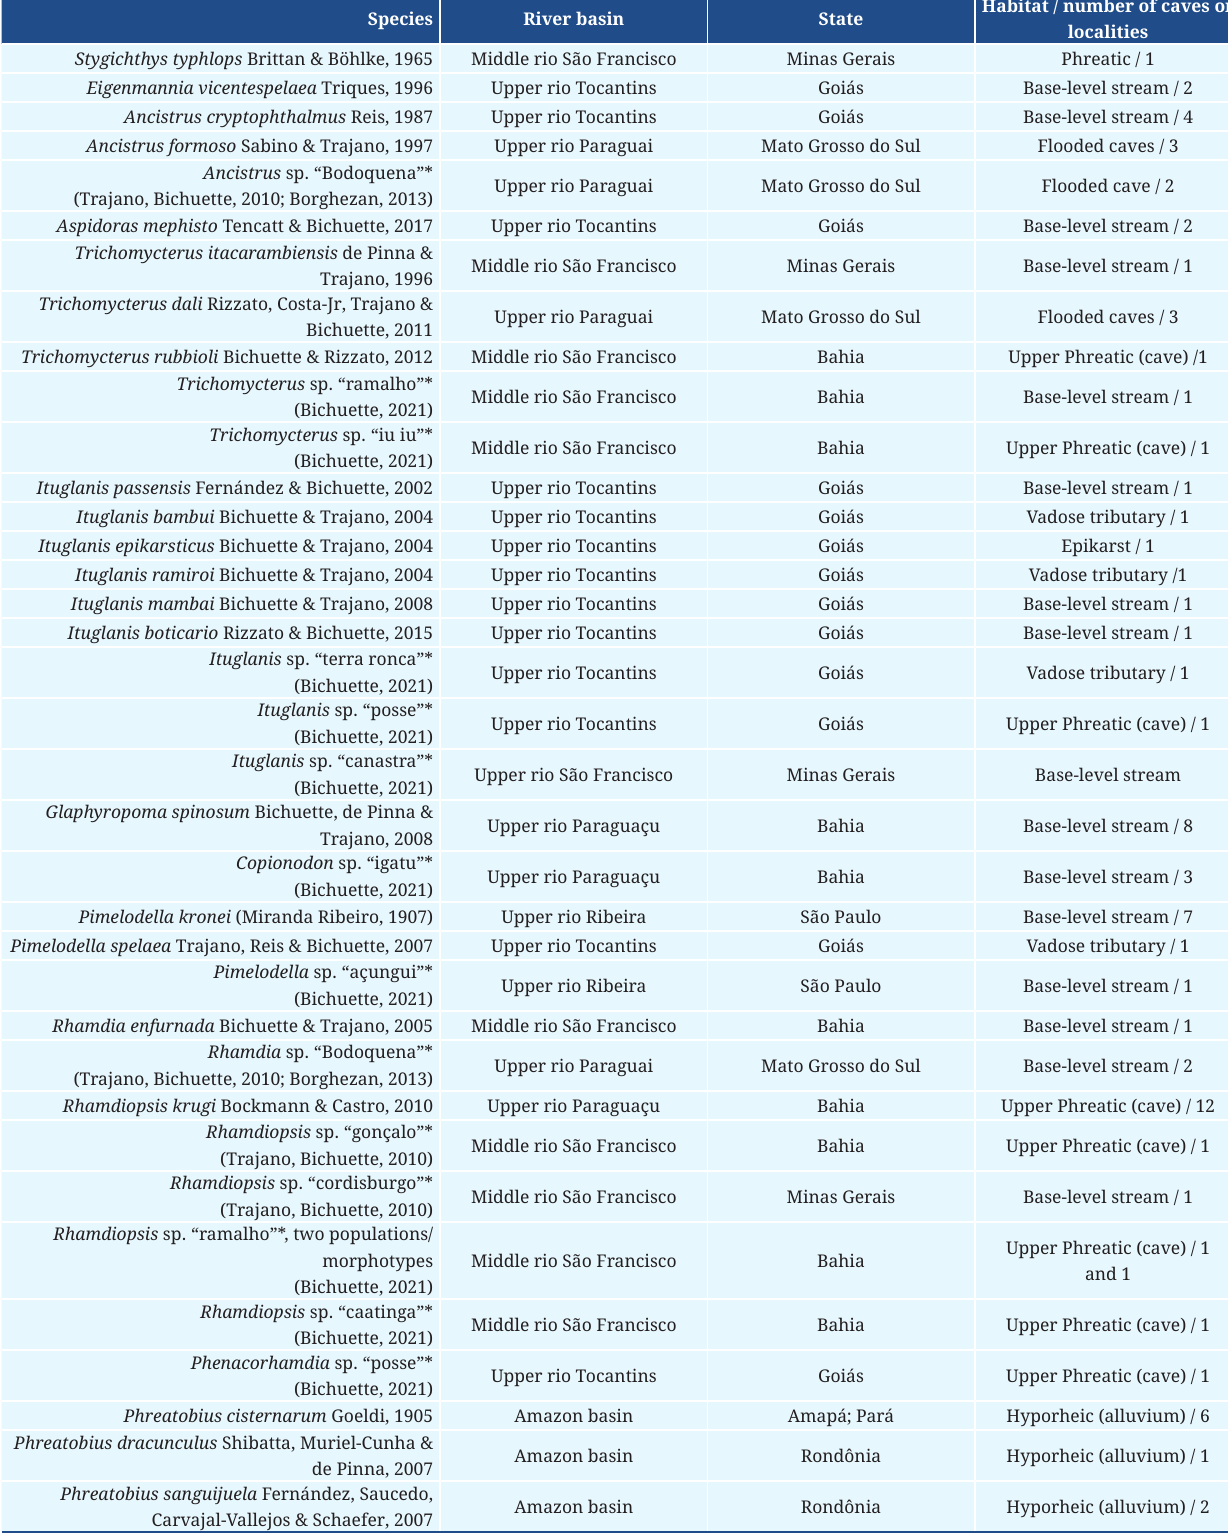
TABLE 1 | List of the currently known Brazilian subterranean fishes species occurring in Brazil, their basins of occurrence, type of habitats / number of localities (caves or non-cave habitats). * Undescribed species with